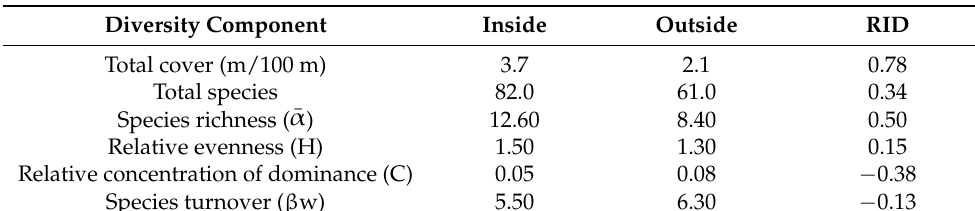
Table 5. Comparison between the total cover of species as well as the species diversity indices inside and outside the enclosures. Relative change increase or decrease (RID) = (inside − outside)/outside. Diversity Component Inside Total cover (m/100 m)